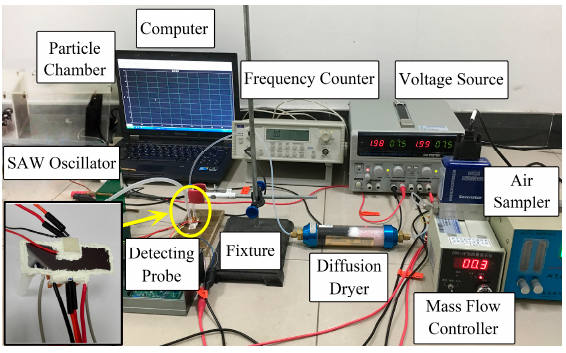
Figure 17. Photograph of the experimental setup.